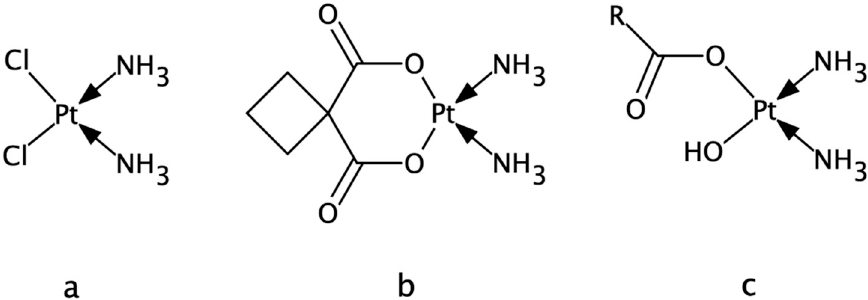
Figure 1. Chemical structures of cisplatin ( a ), carboplatin ( b ) and BP-C1 ( c ). R is a fragment of the BP-Cx-1 ligand with the average molecular weight of 1500–2000 Da.